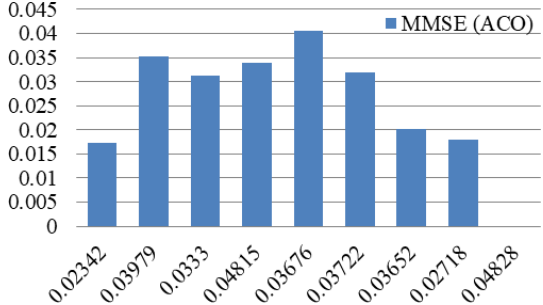
Figure 10: Values of MMSE calculated for various values of µ (ACO)